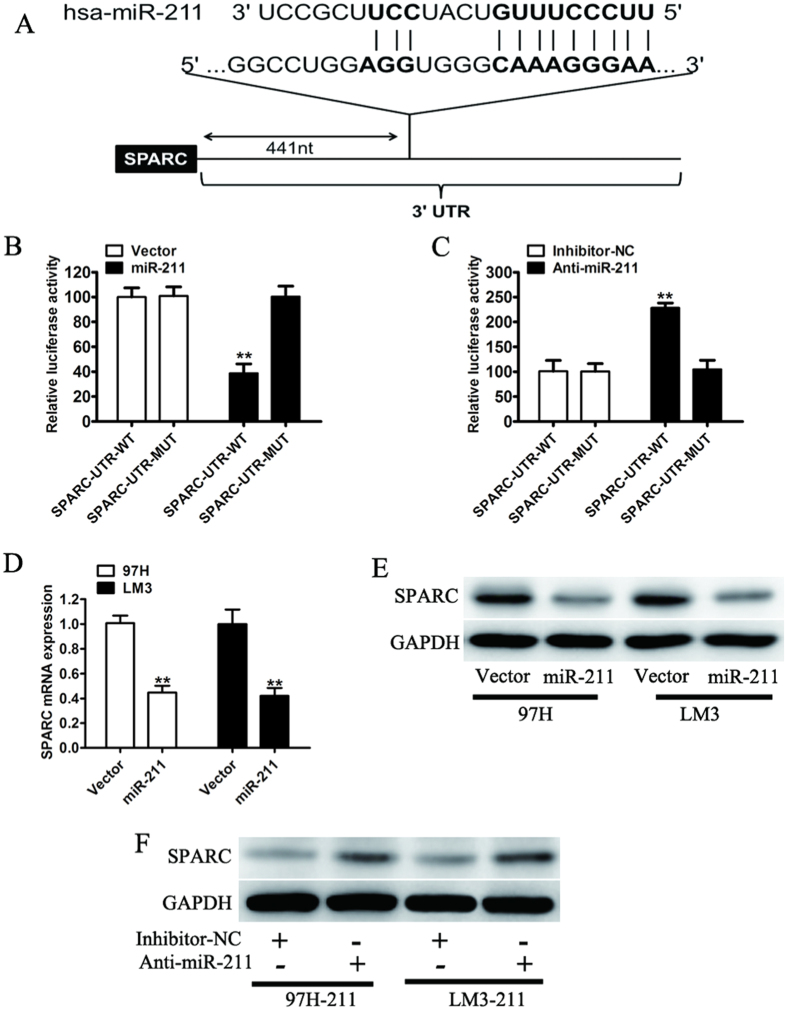
miR-211 regulation of SPARC expression.(A) Computational algorithm showed that the putative miR-211-binding sequence was in the 3′UTR of SPARC. (B) Luciferase reporter construct containing wild-type or mutated SPARC 3′UTRs were cotransfected with vector or miR-211 into 293T cells. (C) 97H cells that were stably overexpressing miR-211 were transfected with either the wild-type or mutated SPARC 3′UTR, along with control inhibitors (inhibitor-NC) or miR-211 inhibitor (Anti-miR-211). Relative Renilla luciferase activity was measured at 48 hours after transfection and normalized to firefly luciferase. (D) The mRNA expression of SPARC in 97H and LM3 cells stably expressing miR-211. (E) The endogenous expression of SPARC was determined by western blotting analysis in 97H and LM3 cells transfected with vector or miR-211. (F) The endogenous protein expression of SPARC in 97H and LM3 cells stably overexpressing miR-211 and transfected with inhibitor-NC or miR-211 inhibitor was analyzed by western blotting. **P < 0.01.